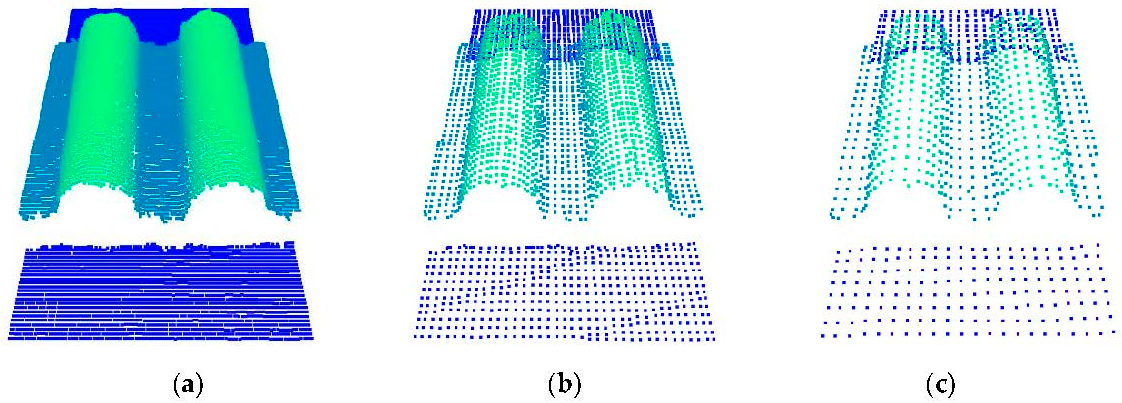
Figure 7. Voxel down-sampling of point cloud with different side lengths: ( a ) r = 0.1 mm; ( b ) r = 0.3 mm; and ( c ) r = 0.5 mm.